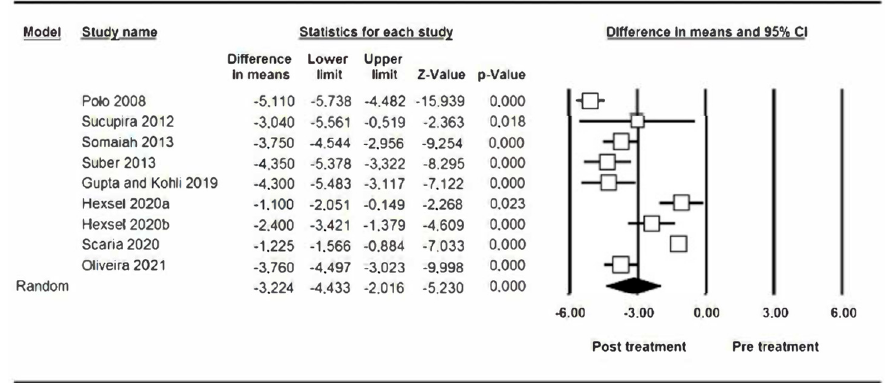
Figure 2. Reduction in gummy smile at two weeks.